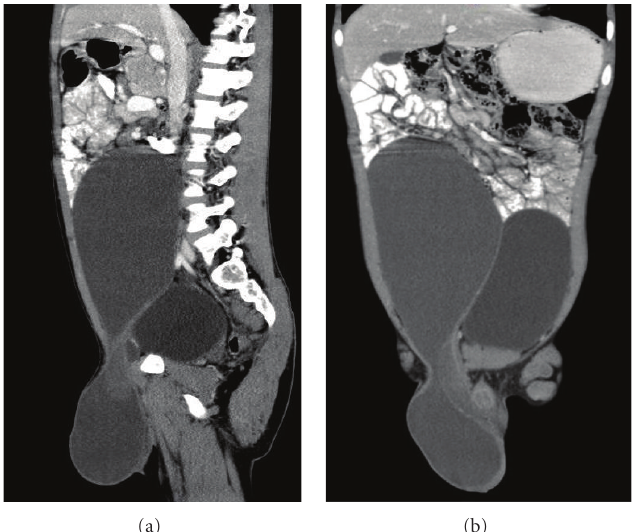
Figure 1: (a) and (b) Coronal and sagittal postcontrast CT images showing a large cystic lesion of thin fluid attenuation in right iliac fossa and lumbar region extending into right scrotal sac. Right testis is located in the right inguinal canal.